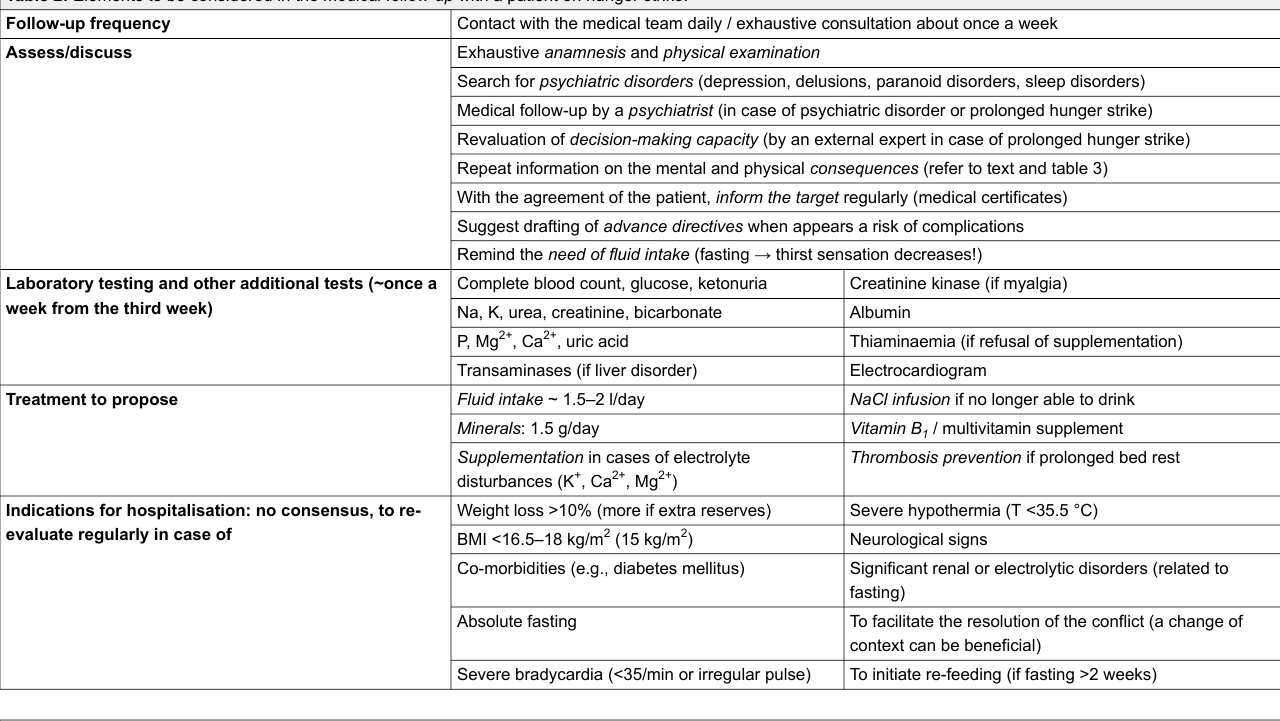
Table 3: Information on the complications of the hunger strike.